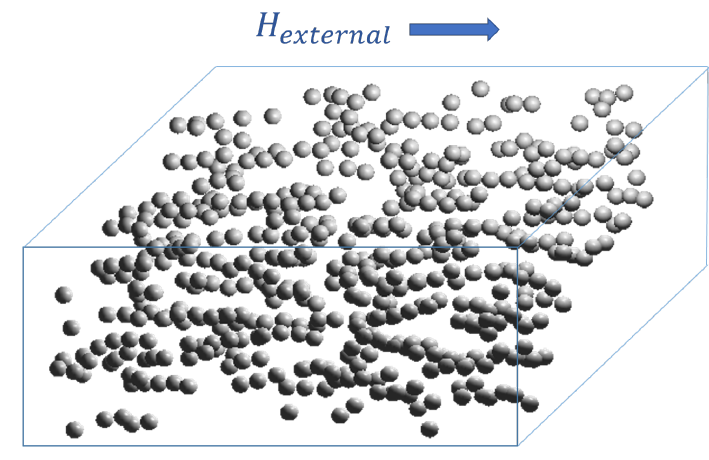
Figure 12. Formation of chain-like structures within the elastomer under applied magnetic